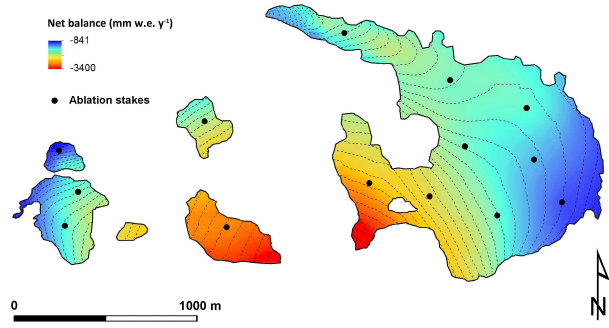
Fig. 9. Spatial distribution of the mean annual (direct) mass balance in the decade from 2003 to